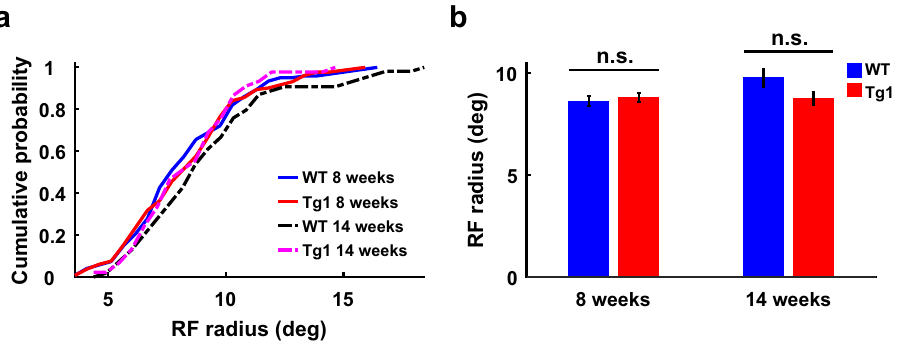
Figure 3. Comparison of RF size between V1 neurons in WT and Tg1 mice. ( a ) Cumulative histograms of RF sizes for V1 neurons in WT and Tg1 mice. ( b ) Mean RF sizes of V1 neurons in WT and Tg1 mice. Error bars, ± s.e.m., P > 0.2, two-way ANOVA followed by Tukey’s multiple comparison test. n = 122 neurons from 16 WT mice at 8 weeks, n = 55 neurons from 11 WT mice at 14 weeks, n = 133 neurons from 16 Tg1 mice at 8 weeks, n = 45 neurons from 12 Tg1 mice at 14 weeks.